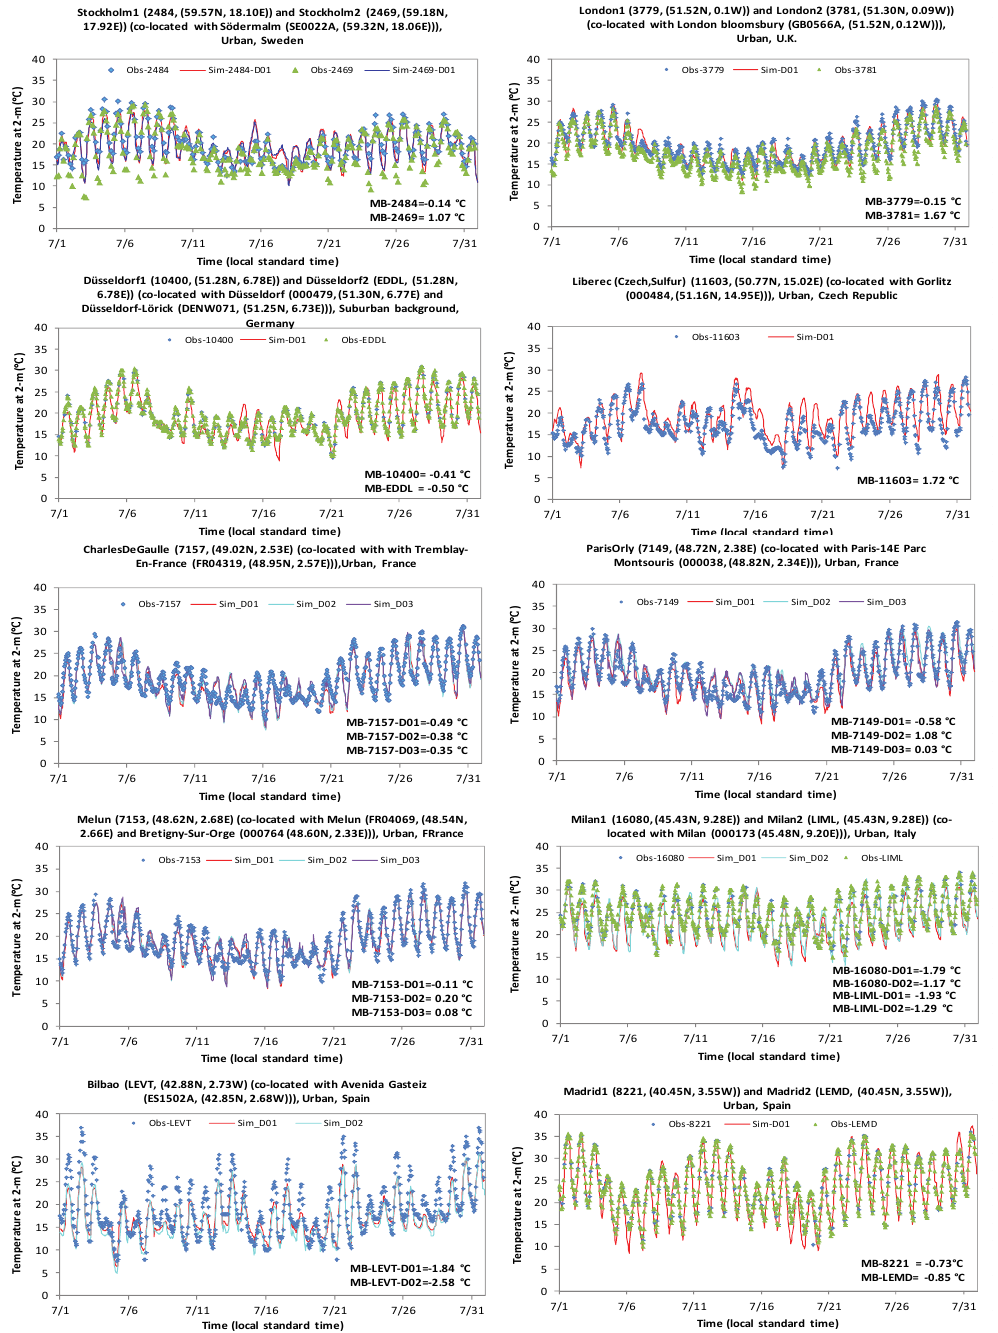
Figure 9. Simulated and observed 2-m temperatures in July 2001 at selected sites. Fig. 9. Simulated and observed 2m temperatures in July 2001 at selected